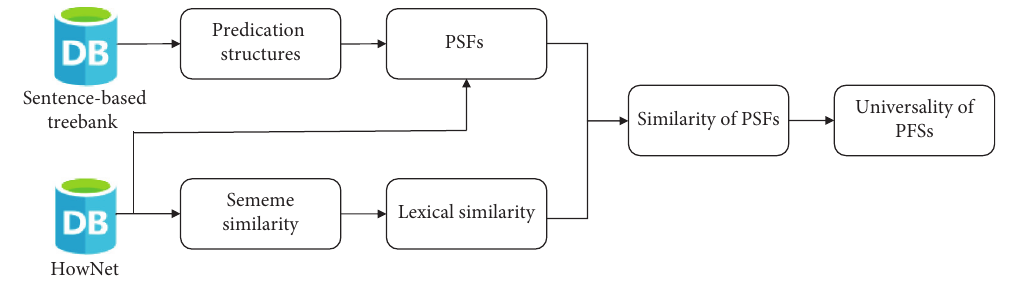
Figure 1: The calculation method of the universality of PSFs.